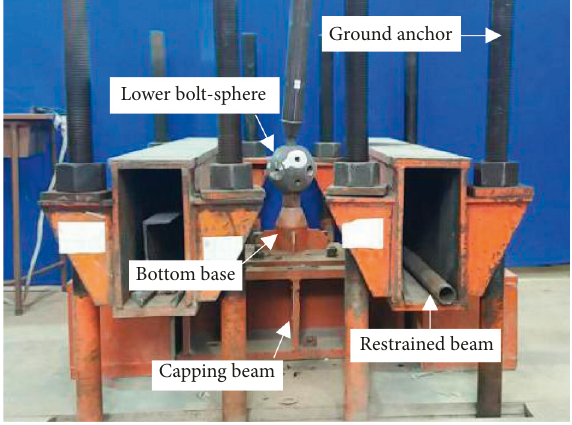
Figure 7: Bottom anchoring